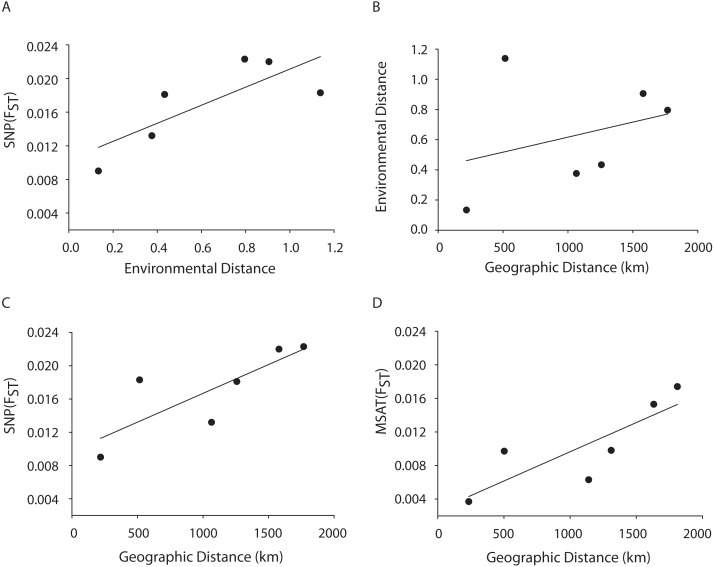
MANTEL matrix correlation test between genetic (Fst), environmental (Euclidean) and geographic distances (km).Acropora palmata samples from four geographic regions (Florida, Bahamas, Puerto Rico and USVI) were genotyped with 307 SNP (A–C) or 10 neutral microsatellite markers (D). (A) y = 0.0107x + 0.0104, R2 = 0.610, p = 0.09. (B) y = 0.002x + 0.4175, R2 = 0.101, p = 0.21. (C) y = 0.000007x + 0.0098. R2 = 0.648, p-value=0.05. (D) y = 0.000007x + 0.0027. R2 = 0.69, p = 0.04.